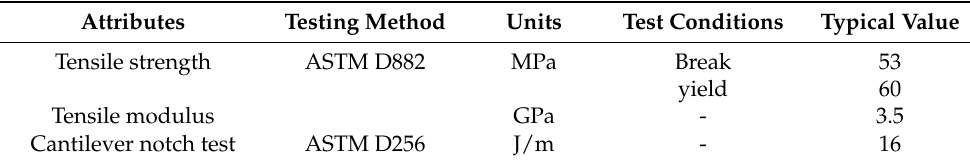
Table 2. Mechanical properties of